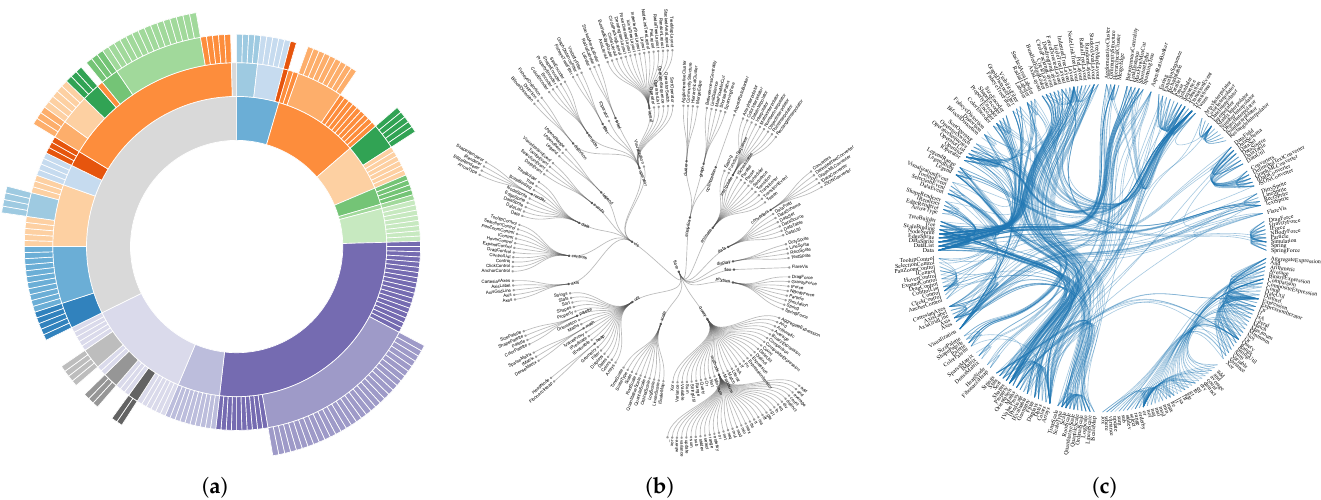
Figure 9. Similar tools to NDR. ( a ) Sunburst Partition tool; ( b ) Radial Hierarchical visualization tool; ( c ) Radial Hierarchical Edge Bounding visualization